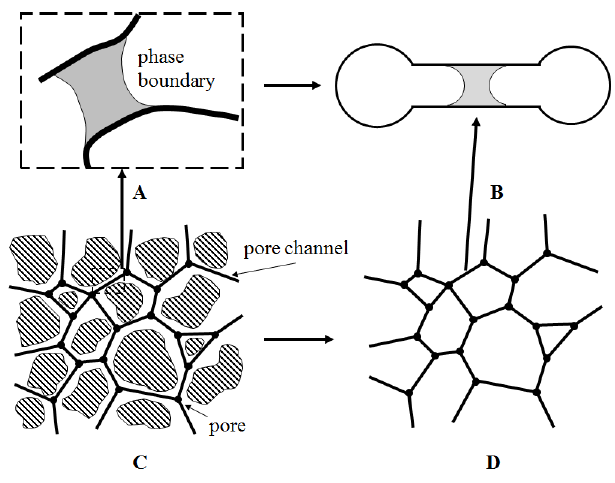
Figure 1. Basic principle of the pore network model. ( A ) Fluid distribution; ( B ) physical simplified model; ( C ) pore space; ( D ) pore network.